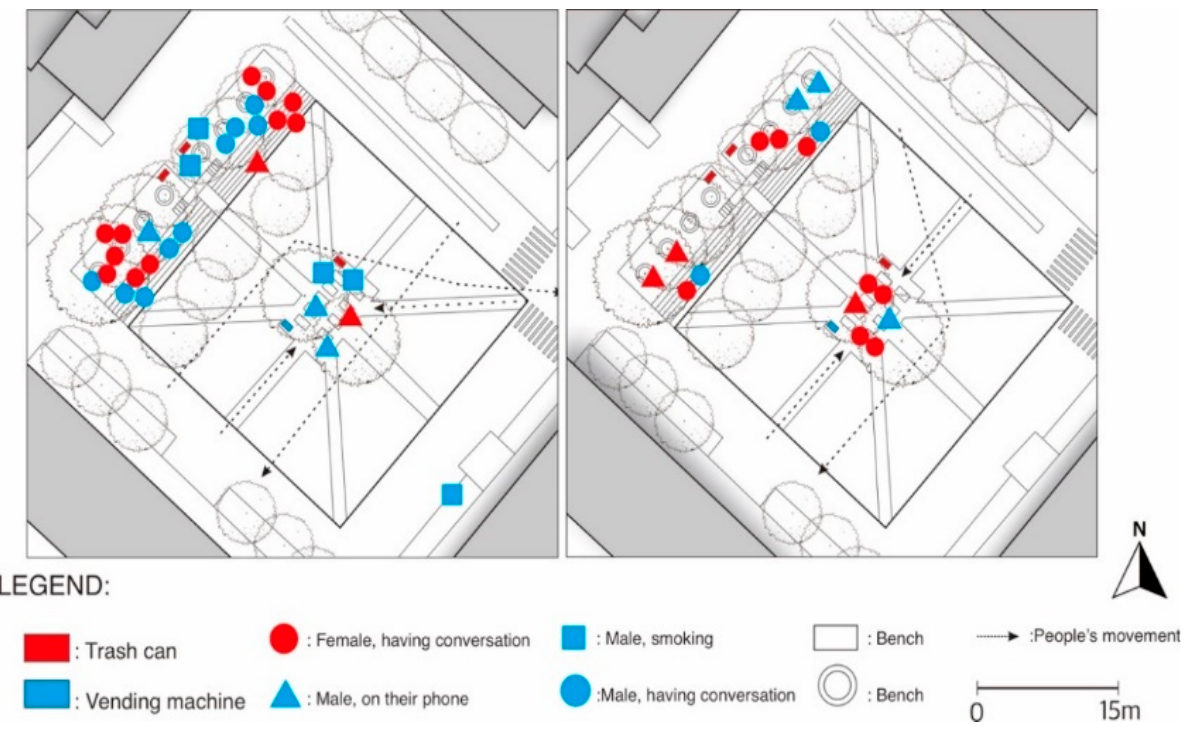
Figure 5. Behavioral map of people engaged in various activities during a weekend at Democratic Plaza (on the left: at 6 p.m., on the right: at 2 p.m.).